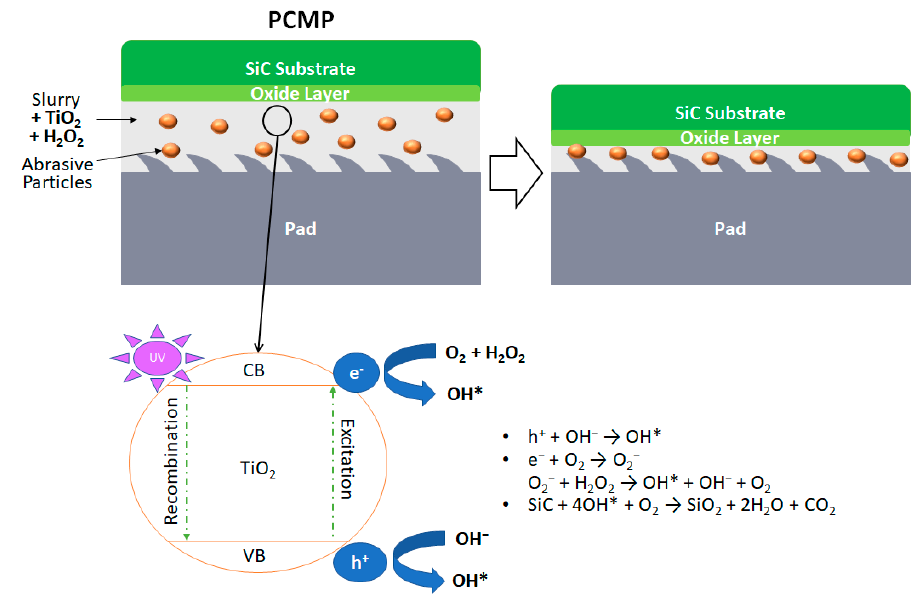
Figure 7. Illustration of PCMP mechanism. Upon irradiation of UV light, the photocatalytic TiO 2 particle reacts with O 2 , H 2 O and OH − in the slurry to generate strong oxidant hydroxyl radical, denoted as OH* [33]. The oxide layer is then removed by the abrasive particles in the slurry and the conditioned CMP pad simultaneously.